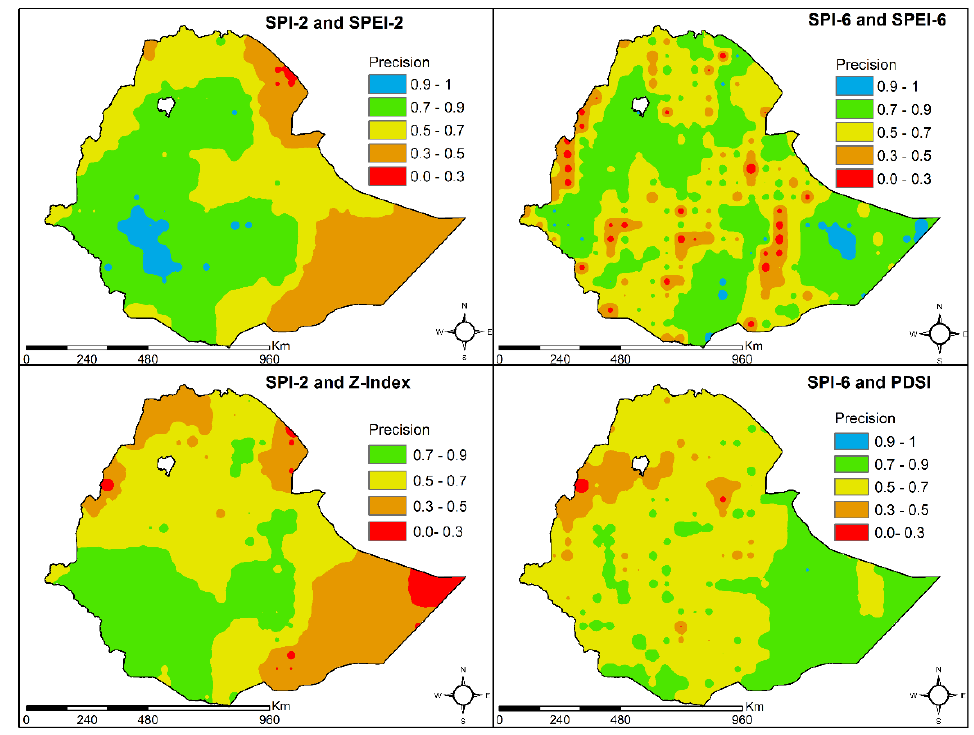
Figure 10. Precision measures of agricultural and meteorological droughts.